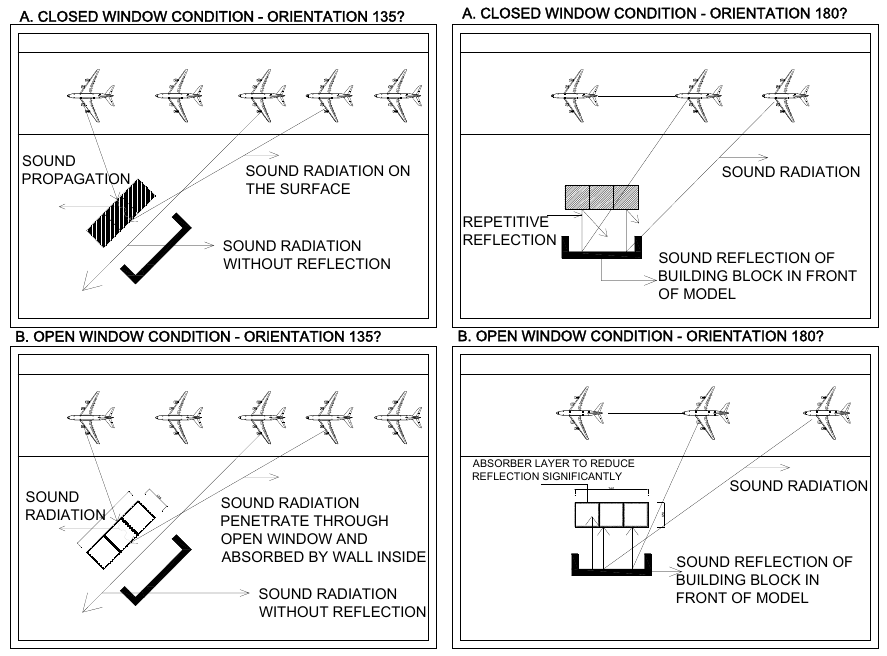
Figure 5. Reflection and absorption in orientation 135 ° and 180 ° .